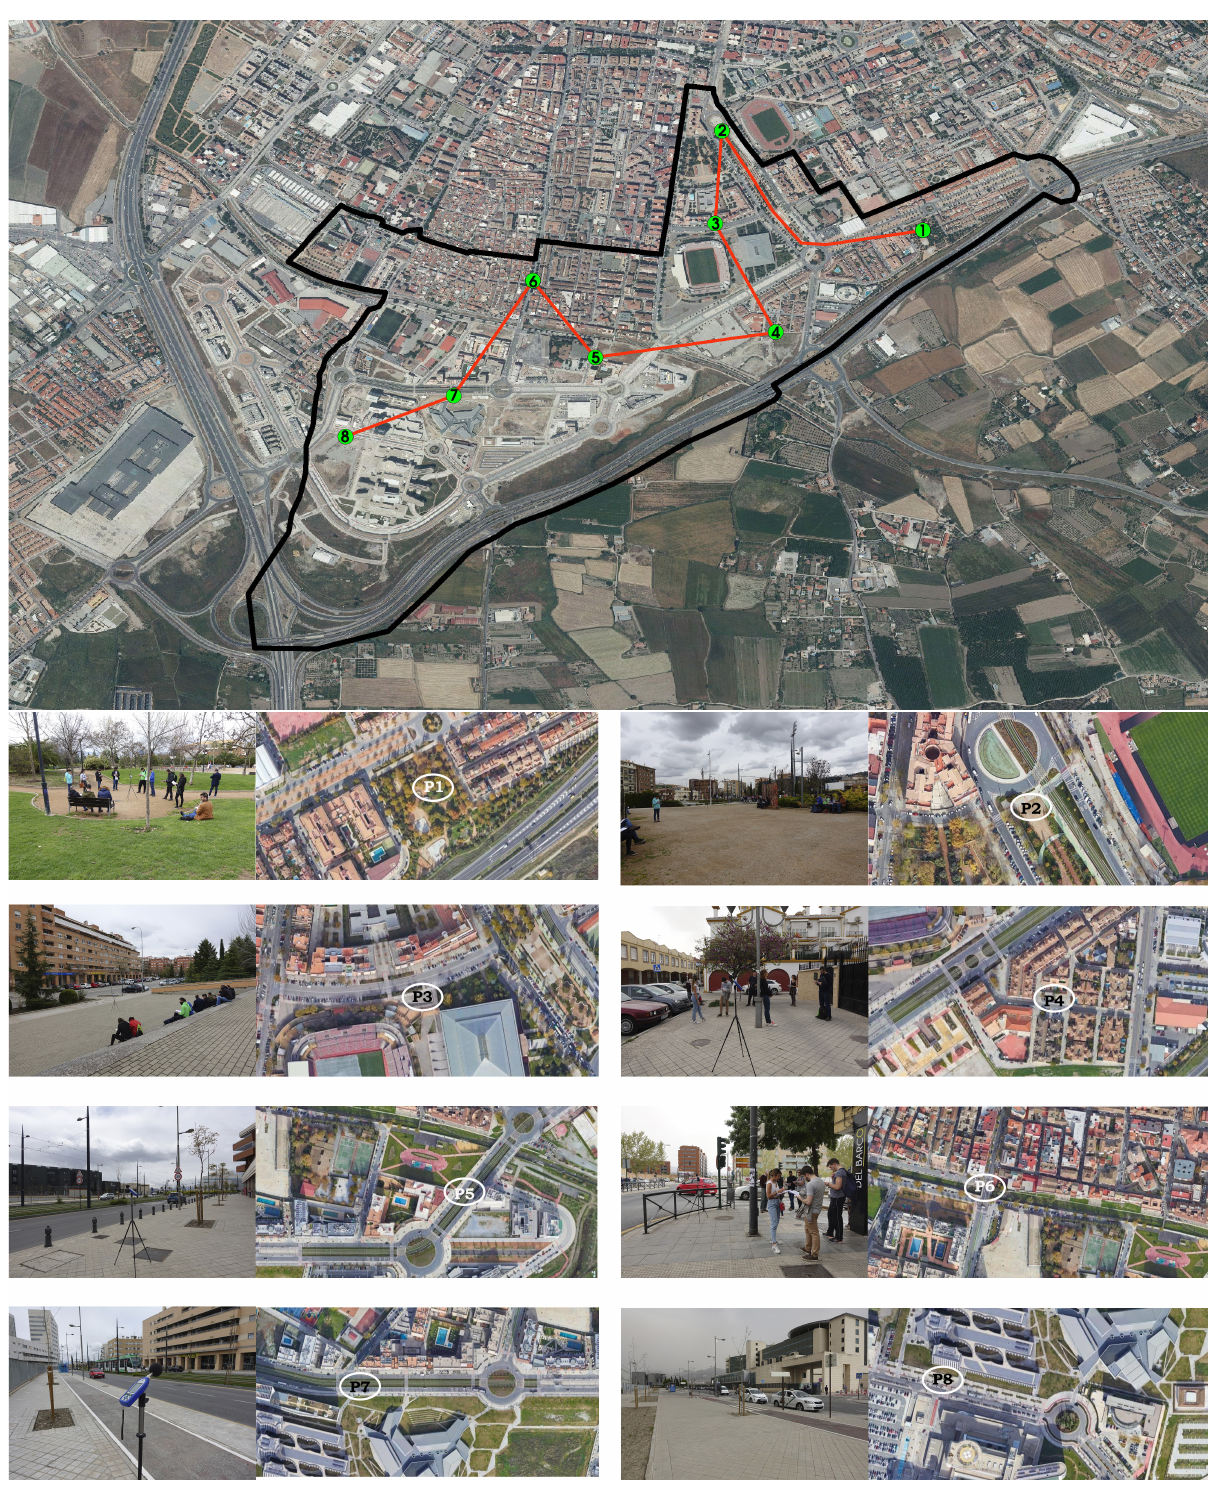
Figure 6: Soundwalk path across PTS study area and photographic description of the eight evaluation stops (P1 to